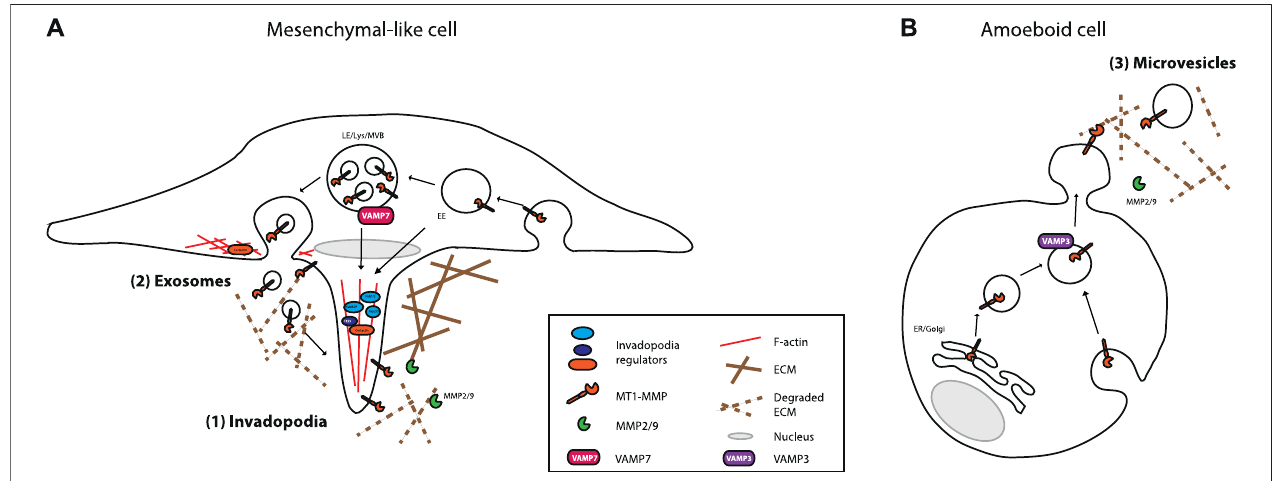
FIGURE 2 | MT1-MMP main vesicular traf fi cking routes and sites of release/secretion. (A) Mesenchymal invading cells deliver MT1-MMP containing vesicles to degradative actin-rich membrane structures, called invadopodia (1), and in the extracellular microenvironment as associated to exosomes (2), after fusion of MVB with the invadopodial plasma membrane. Invadopodia are preferential sites of exosome secretion and exosomes potentiate invadopodia formation and proteolytic activity. (B) Amoeboid/blebbing invading cells release MT1-MMP associated to microvesicles (3) shed from the plasma membrane. Newly synthetised (not depicted for mesenchymalcells)andrecycledMT1-MMPtraf fi cktothesedifferentlocations.TheendosomalSNARE,VAMP-7isimplicatedinthetraf fi ckingofMT1-MMP-containing vesicles to invadopodia and associated to exosomes, whereas the endosomal SNARE, VAMP-3 delivers MT1-MMP to microvesicles shed from the plasma membrane. Please refer to the main text for further details. LE, Late Endosome; Lys, Lysosome: MVB, Multi Vesicular Bodies; EE, Early Endosome.